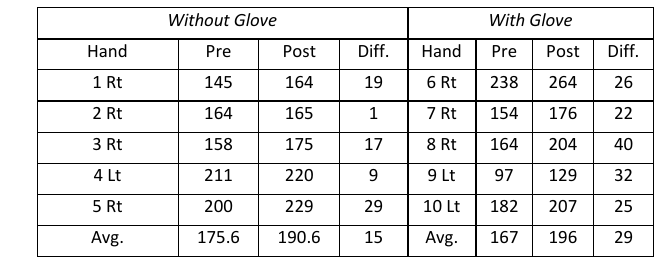
B. Function “With glove” group participants showed a significantly greater improvement on the GRT (GRTmeanwith = 29) than the “without glove” group (GRTmeanwithout = 15), p = 0.02, 95% confidence interval of 0.5 through 27.5, Cohen's d: 1.55, indicating a very high effect [24]. GRT data are shown in Table 4 and Fig. 13. In the case of the GRT, an increase represents an overall increase in the number of correctly completed repetitions of a given activity in the test. Thus, a positive change in value is considered desirable in this